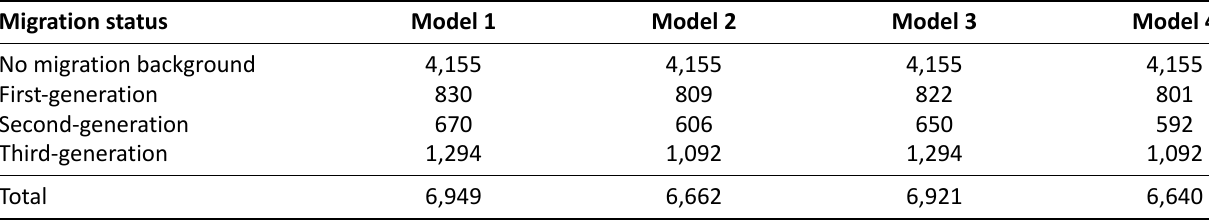
Table A3. Compositions of the samples used in the four